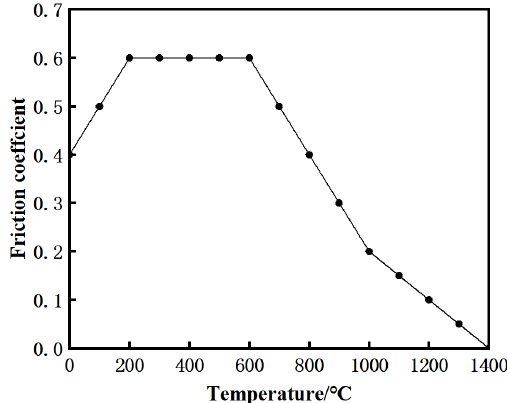
Figure 3. Friction coefficient under different temperatures.